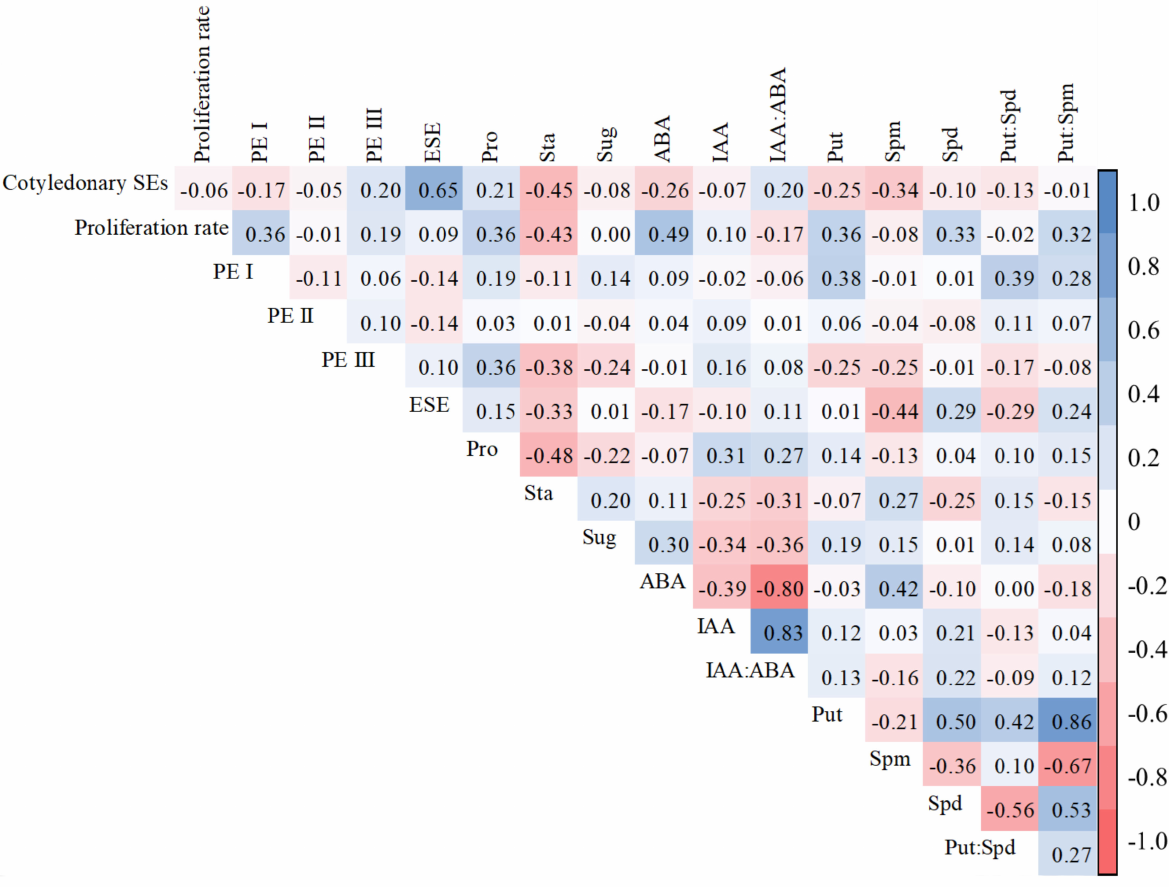
Figure 5. Correlation between cotyledonary SE yield and morphological and physiological indicators in different cell lines of P. koraiensis. The numbers in the figure are correlation coefficients (R-values). The larger the R-value, the stronger the correlation. 2.3. Differences in the Number of ESEs between Different Cell Lines of P. koraiensis The numbers of PE III ( p = 0.011, R = 1.9, B = 1.2) and ESEs ( p < 0.001, R = 1.7, B = 0.6) in R cell lines were significantly higher than those in B cell lines. The number of PE III in